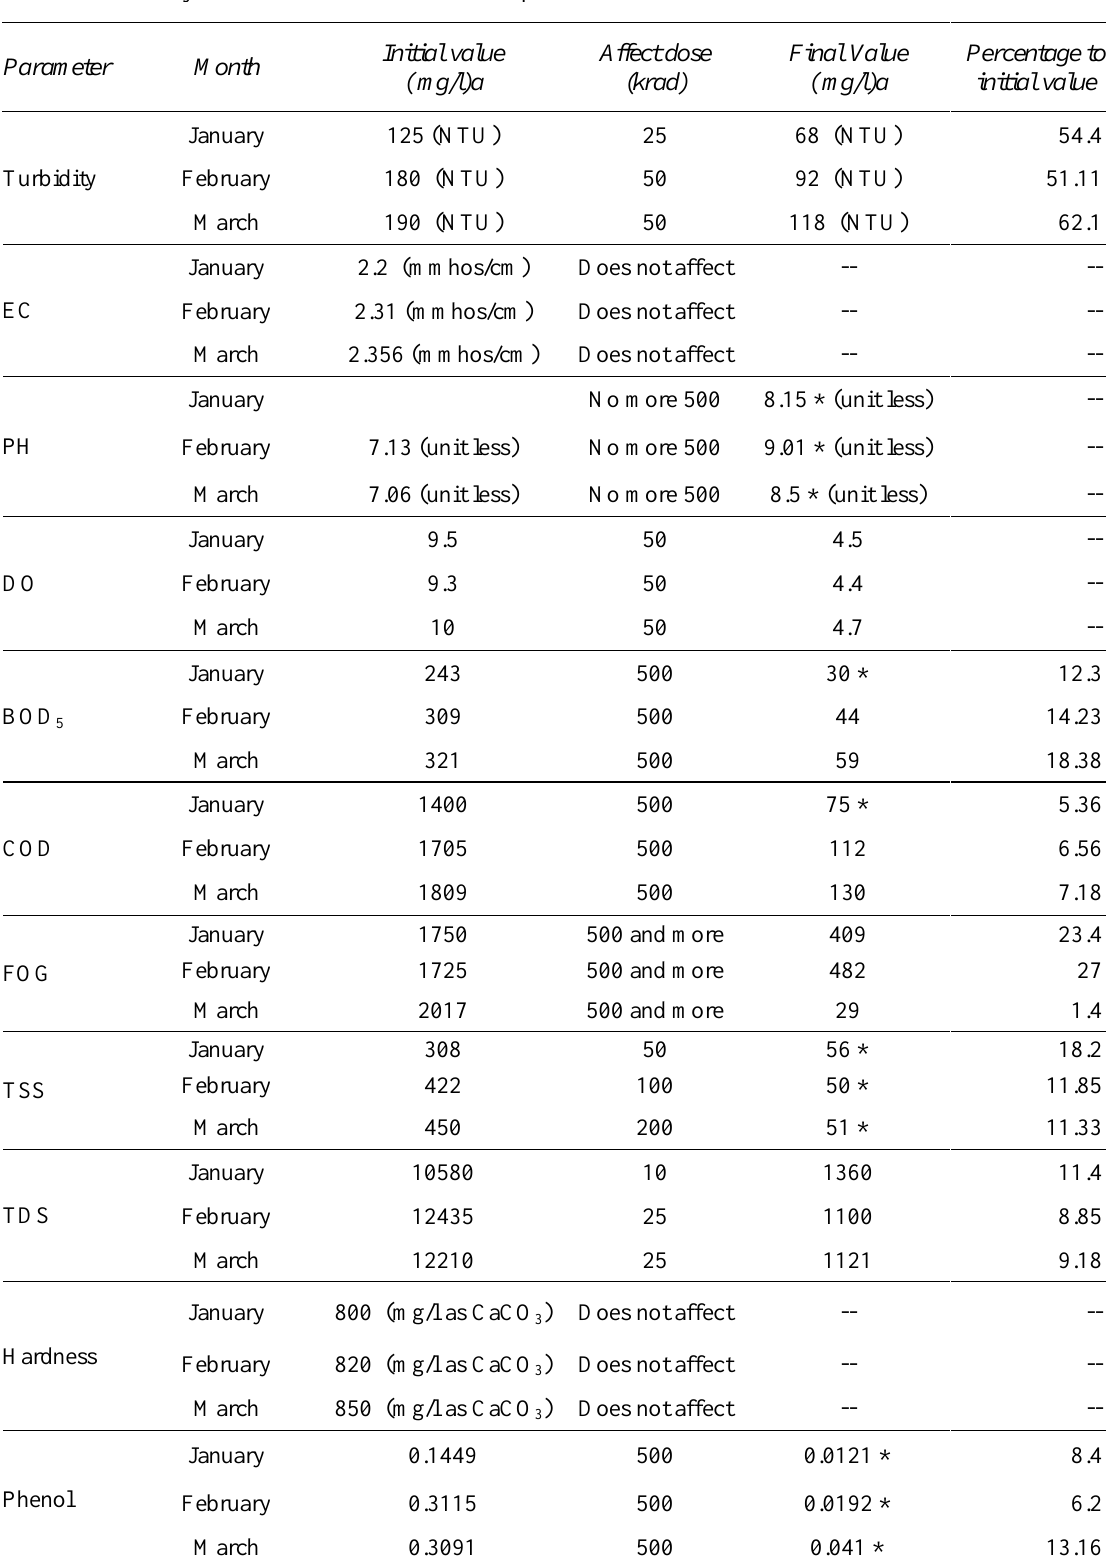
Table 1: Summary for the conventional result of experimental